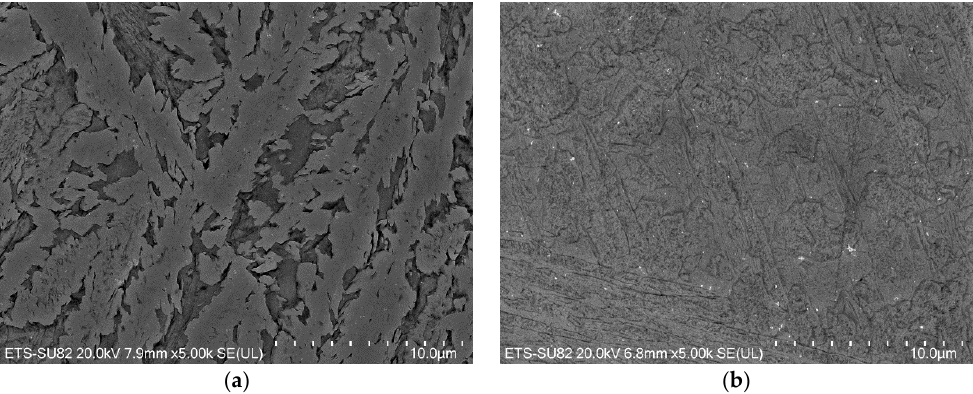
Figure 17. SEM images of the obtained microstructure after cooling: ( a ) Martensite at 3 °C/s; ( b ) Bainite at 0.015 °C/s.